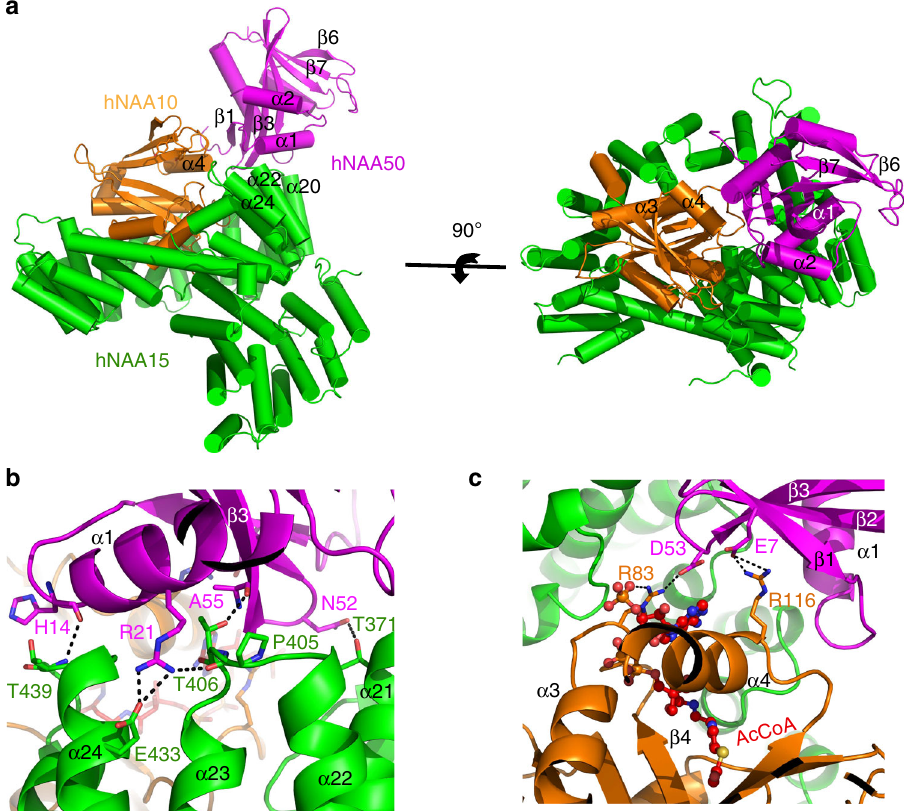
Fig. 4 Cryo-EM structure of the hNatE complex. a hNAA50(magenta), hNAA15(green), and hNAA10(orange) within the hNatE complex shown in cartoon. b Zoom-in view of the contacts between hNAA15 and hNAA50 with residues that participate in interaction labeled. c Zoom-in view of the contacts between hNAA10 and hNAA50 with residues that participate in interaction shown. Acetyl-CoA bound to hNAA10 is shown in ball and